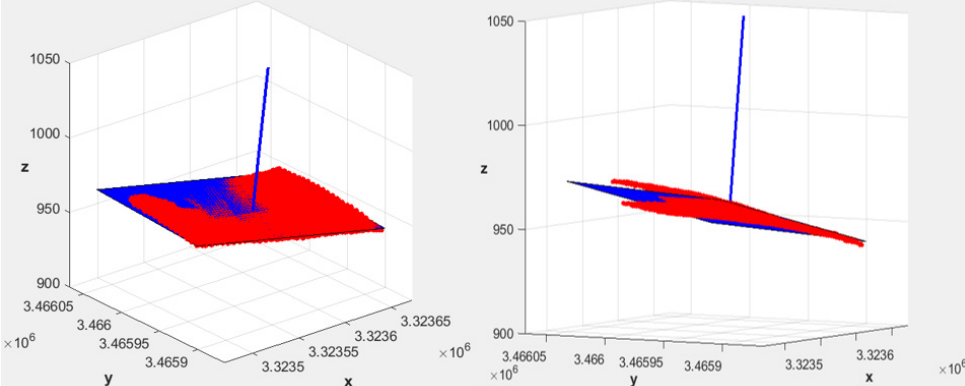
Figure 4. Two different 3D views of sector #4 belonging to the apple farm subdivided in five sectors (numbered in Figure 3a), and the corresponding equivalent sector (blue color) with uniform slopes (S 0, L = − 0.054 and S 0, M = − 0.180). The parameters corresponding to the position of the manifold ( BMP ) and that of the water inlet into the manifold ( BIP ) were selected (Figure 1) according to the slopes of the actual 5 sectors, which correspond to Layout #6 (for sectors #1, #2, and #3) and to Layout #7 (for sectors #4 and #5).